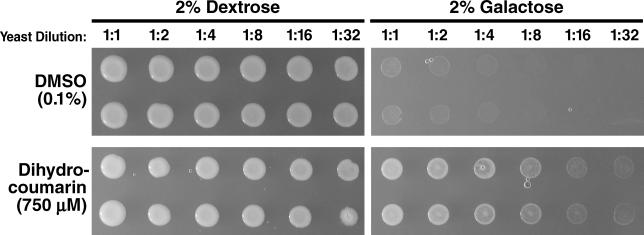
DHC Reverses the Lethal Phenotype of Galactose-Induced Plasmid SIR2 OverexpressionTwo-fold yeast serial dilutions were used for this assay. Growth is observed on 0.1% DMSO and 750 μM DHC in dextrose medium. The lethal SIR2 phenotype is observed on the 0.1% DMSO galactose medium but is partially reversed on the 750 μM DHC galactose medium.